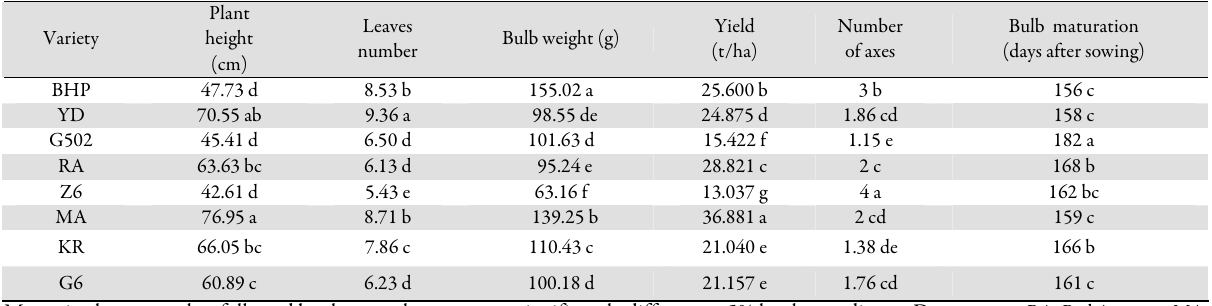
Tab. 3. Performance of onion cultivars cultivated under temperate conditions of